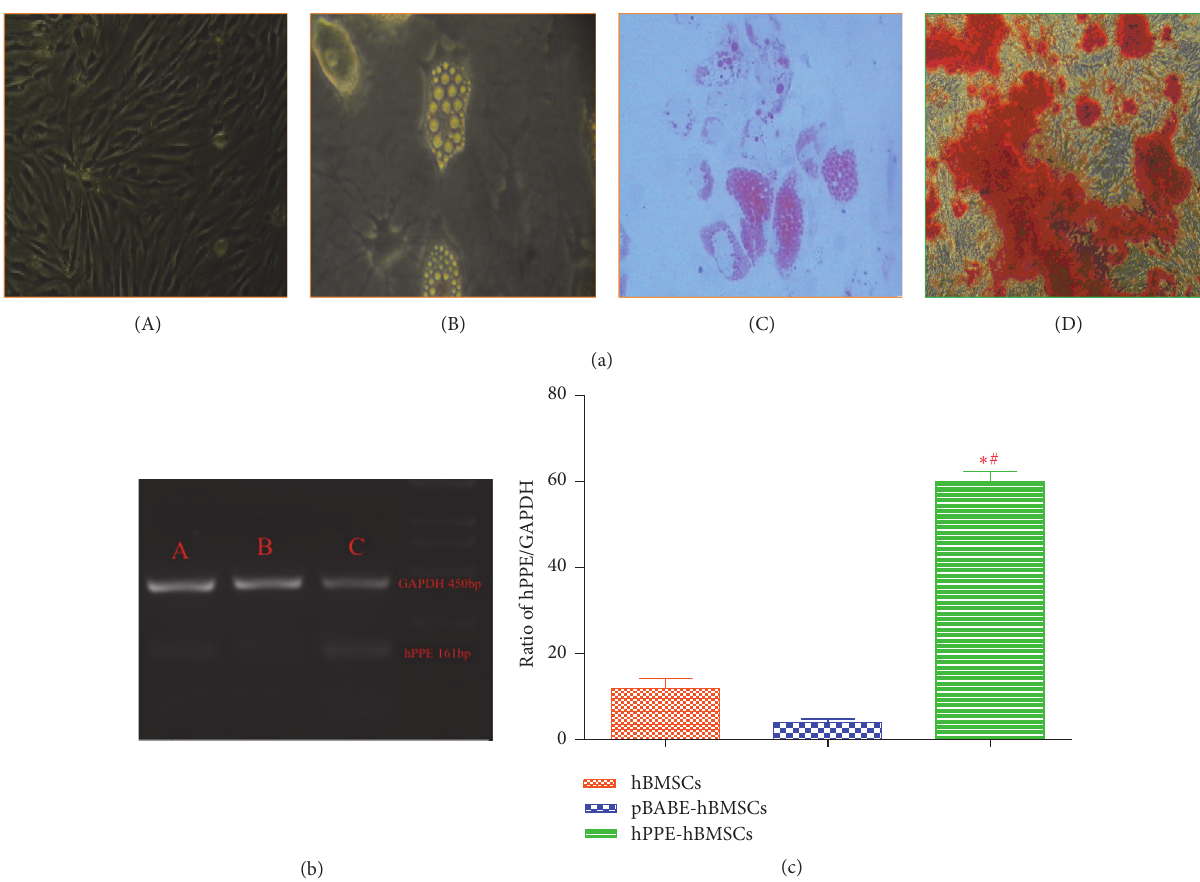
Figure1:(a)Identificationofthehumanbonemarrowstemcells(BMSCs),includingculture,differentiation,andapplication,wasanalyzedby immunohistochemistry.(A)ThemorphologyofBMSCsatpassage3(scalebar=100 𝜇 m).(B)Adipogenicdifferentiationbeforestaining(scale bar = 100 𝜇 m). (C) The cultured cells were stained with Oil Red O solution (scale bar = 100 𝜇 m). (D) Osteoblasts were stained with